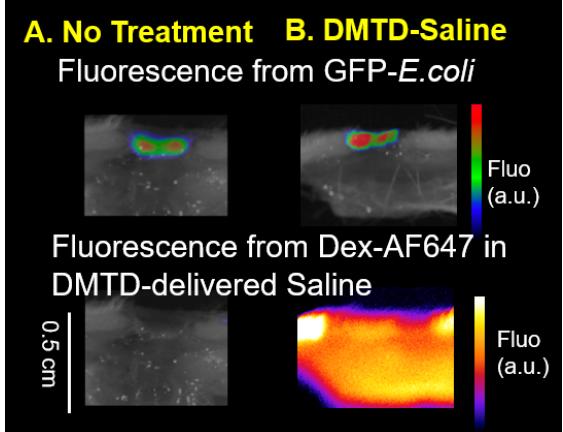
Figure 10. Representative images of rat skin wounds infected with GFP- E. coli. The depth of GFP fluorescence was similar in untreated wounds ( A ) and wounds treated with 1 min delivery of 600 µL of DMTD-delivered saline containing the fluorochrome DEX-AF-647 ( B ). n = 3 for all groups. DEX-AF-647 in the DMTD-delivered saline reached 5 mm depth in the skin indicating that the DMTD delivery was successful. a.u. Arbitrary Units; Fluo: Fluorescence.